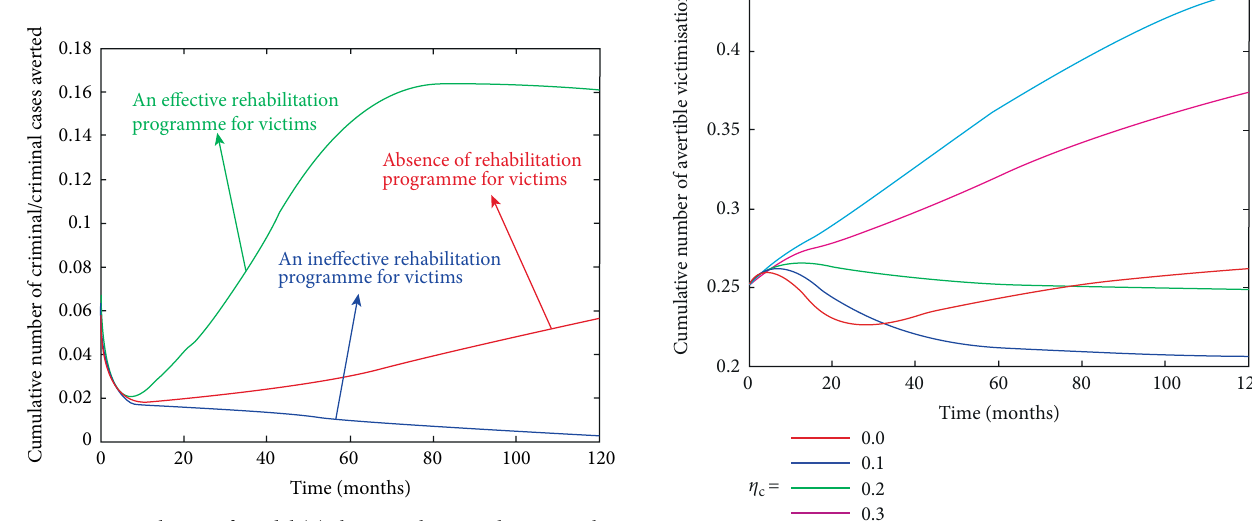
Figure 5: Simulation of model (4) showing the cumulative number of criminals and criminal cases averted as a function of time for . Other parameter values used are as in Table 3. different values of 𝜏 2